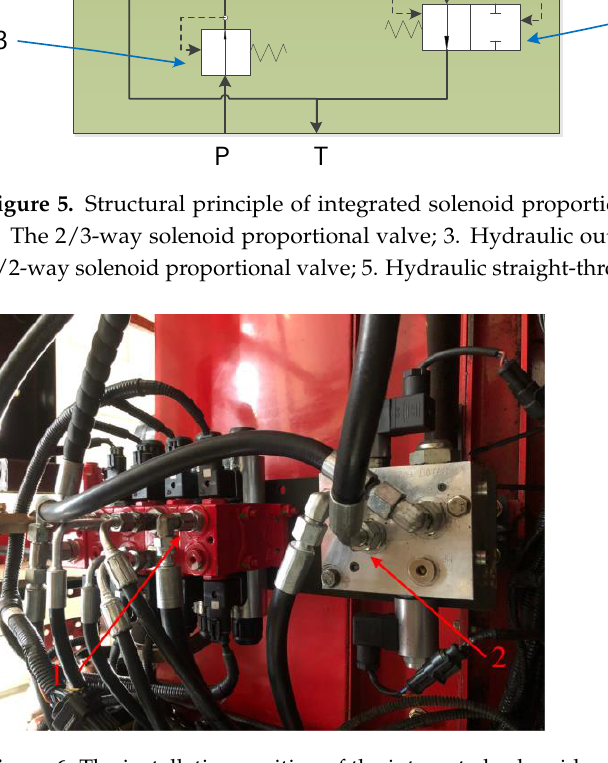
Figure 6. The installation position of the integrated solenoid proportional valve. 1. Original electric control valve; 2. Retrofitting an integrated solenoid; 3. Proportional valve.